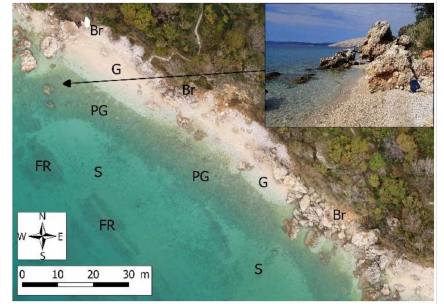
Figure 9. The beach and cliff formed in talus breccia (near cross-section C , Figure 4): Br—talus breccia, G—fine to coarse gravel, PG—pebbles and coarse gravel, S—sand, FR—flysch rock. Narrow beaches near cross-sections B and D are formed in front of cliffs composed of flysch rock mass (Figures 4 and 5B,D). The sand layer here is very thin and flysch outcrops are visible on the seabed. The granulometric composition of the beach at this site is also patchy and the small thickness of its body may lead to flysch rocks being visible